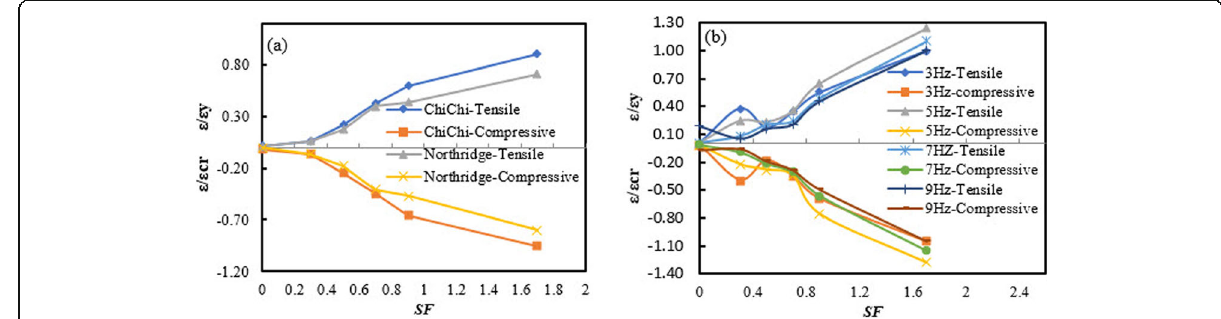
Fig. 13 Effect of SF on pipeline strains: ( a ) Chi-Chi and Northridge input motion; ( b ) harmonic input motion at PGA = 0.8 g